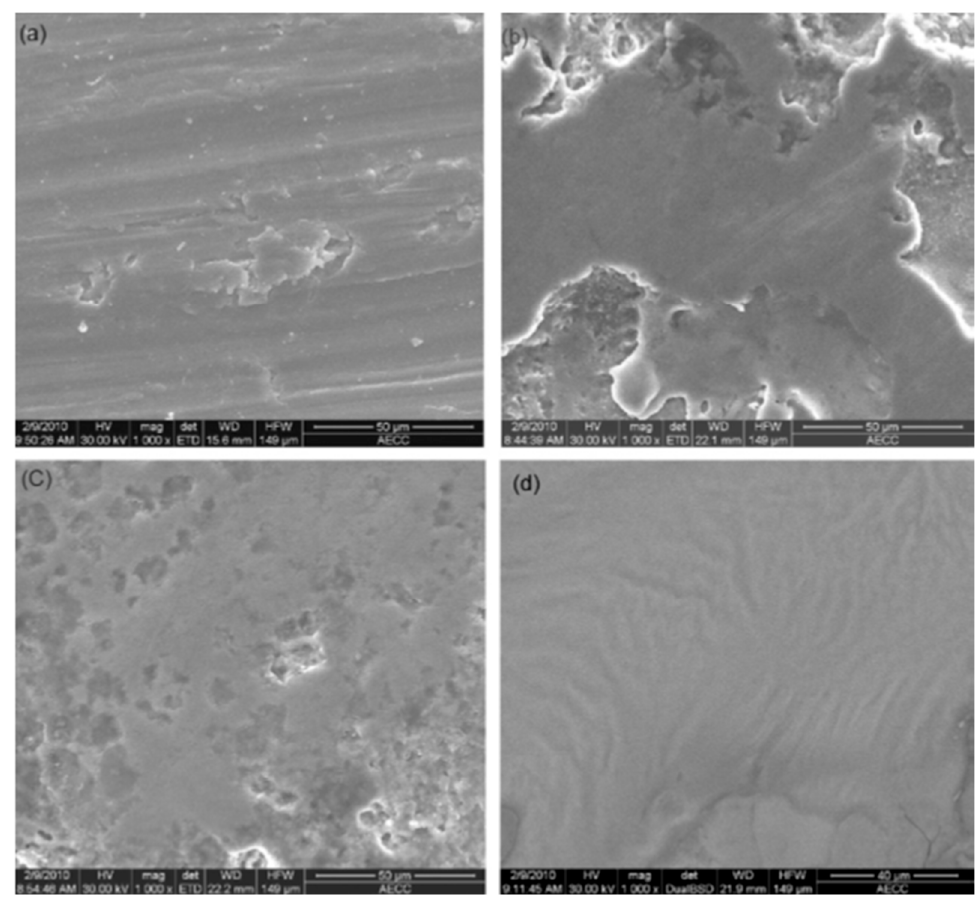
Figure 4. Scars produced due to corrosion in the ( a ) Ti-6Al-4V alloy, ( b ) ESA in air, ( c ) ESA in N 2 , and ( d ) ESA in silicone oil [44]. (With kind permission from Elsevier).